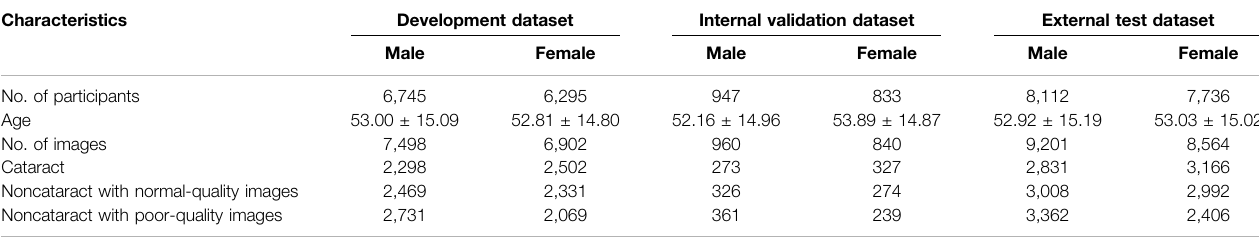
TABLE 1 | Characteristics of the development, internal validation, and external test dataset.